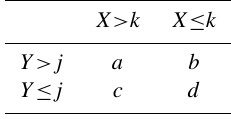
Table 1. Example of contingency table for variables X and Y, k and j being the threshold for X and Y